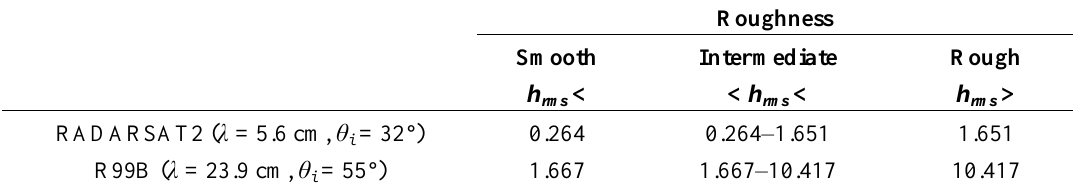
Table 4. Limits of the roughness categories calculated according to the criterion of Peake and Oliver [41] for the RADARSAT-2 and R99B images. The first column shows the wavelength ( λ ) and angle of incidence ( θ ) values for each type of i